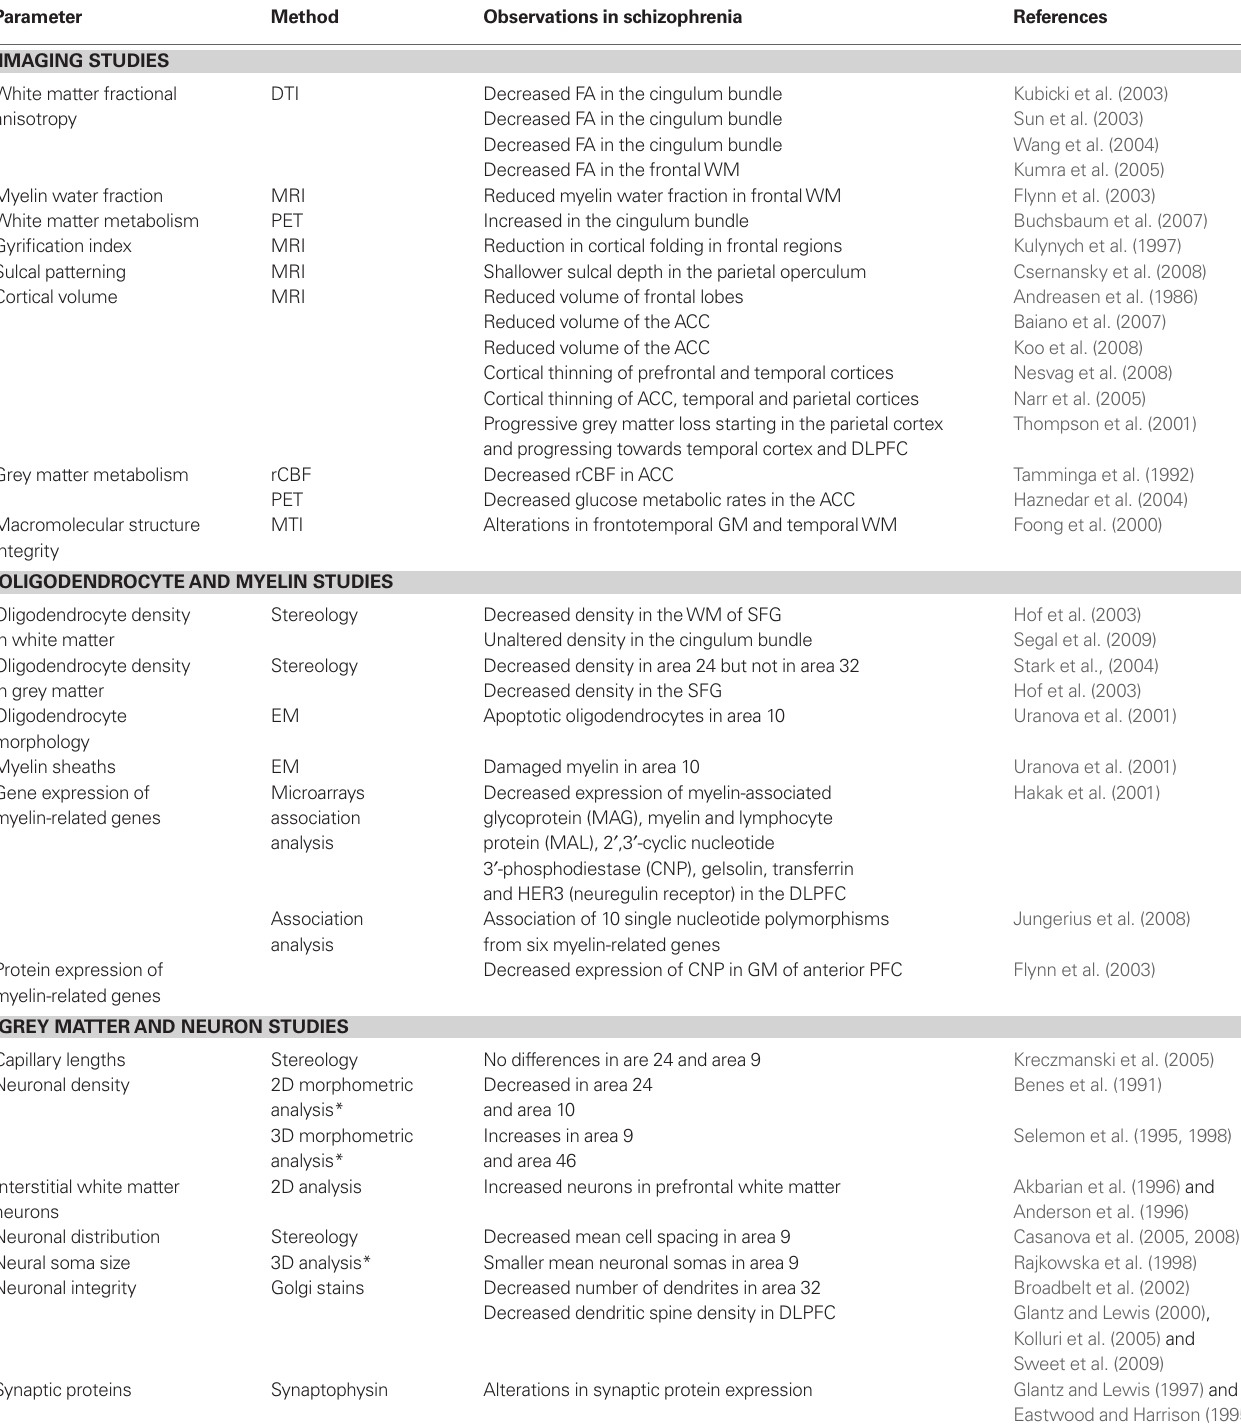
Table 1 | Examples of neuropathological observations on the human cerebral cortex and underlying white matter in